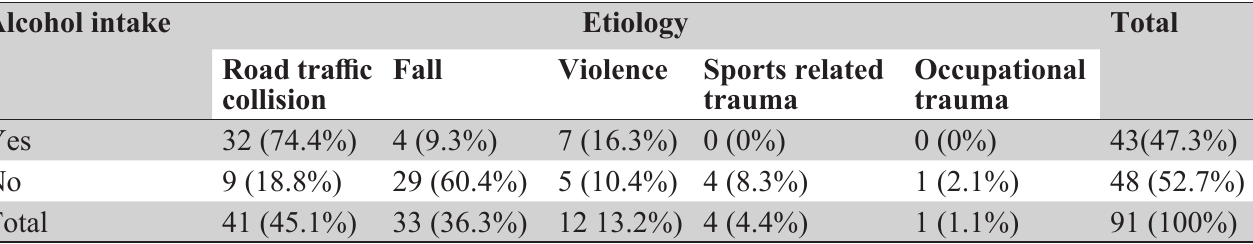
Table 2. Relationship between etiology of fracture and alcohol consumption during the time of occurrence of